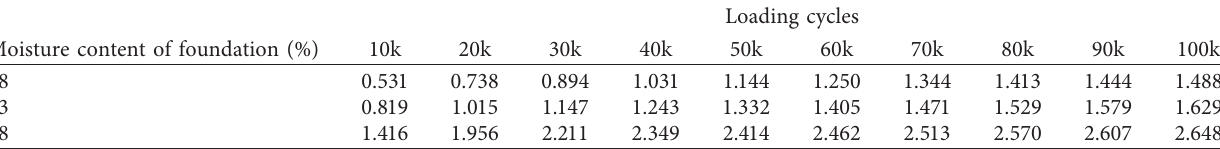
Table 6: Strain accumulation rate within 0.2m of the top layer of the foundation.